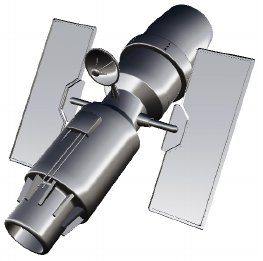
× 30.37 m × 20.74 Figure 12. The side view of the model of typical satellite (40.09 m × 30.37 m × 20.74 m). Figure 12. The side view of the model of typical satellite (40.09 m Figure 12. The side view of the model of typical satellite (40.09 m × 30.37 m × 20.74 m). Figure 12. The side view of the model of typical satellite (40.09 m × 30.37 m × 20.74 m).